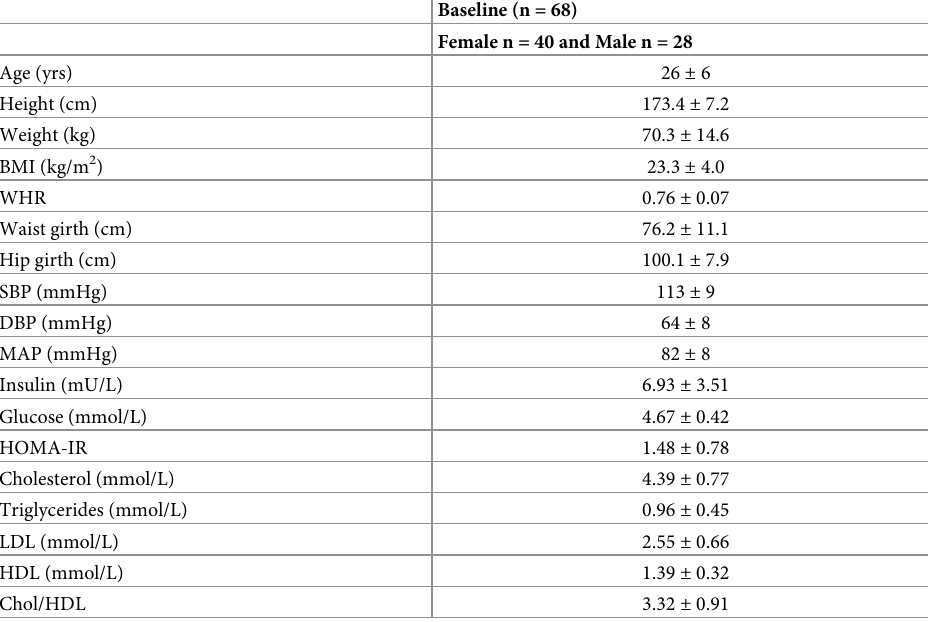
Table 1. Baseline characteristics of participants enrolled in the